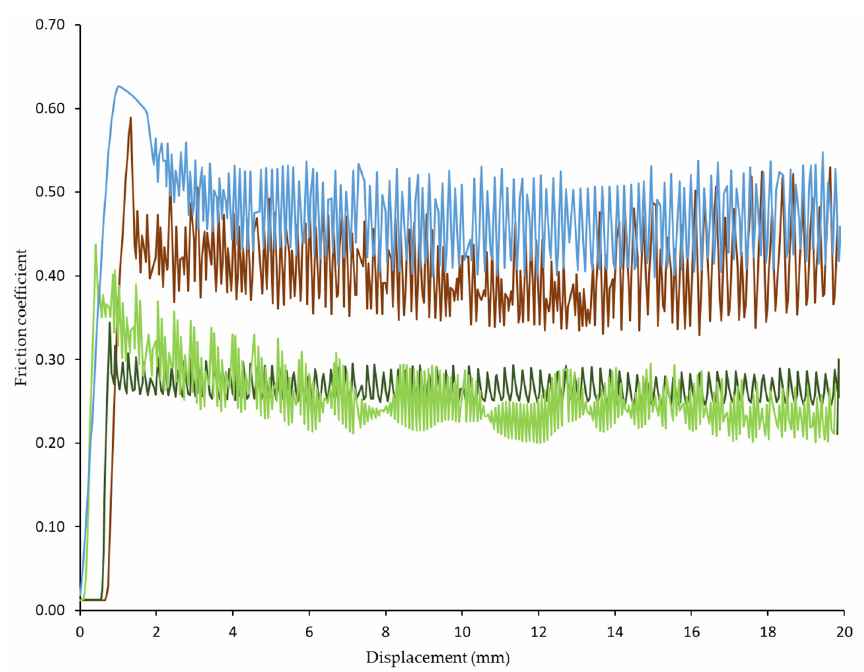
Figure 7. Representative examples of the variation of the coefficient of friction against the displace- ment for the different combinations of surfaces and sliding directions: ▬ A–C; ▬ A–E; ▬ B–C; ▬ B–E.